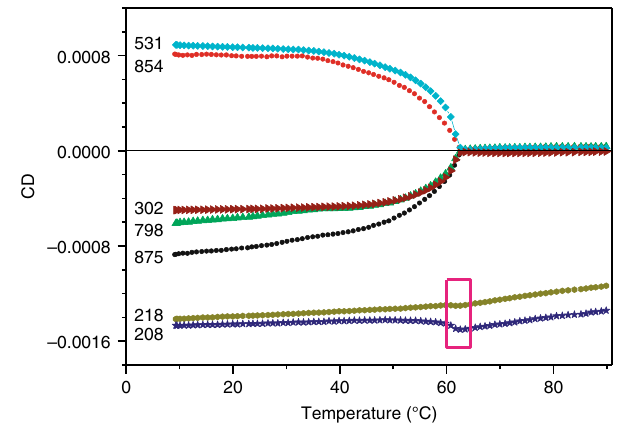
Fig. 4 Intensity of selected CD lines as a function of temperature. Temperature dependence of the CD signal intensities at the wavelengths indicated in nanometers. The initial optical density of the sample in 1 mm cuvette at 858 nm was 0.62. The sample temperature was raised with a rate of 1 °C/min; measurement time per temperature point was ∼ 1 min. The pink rectangle highlights the change of the protein CD